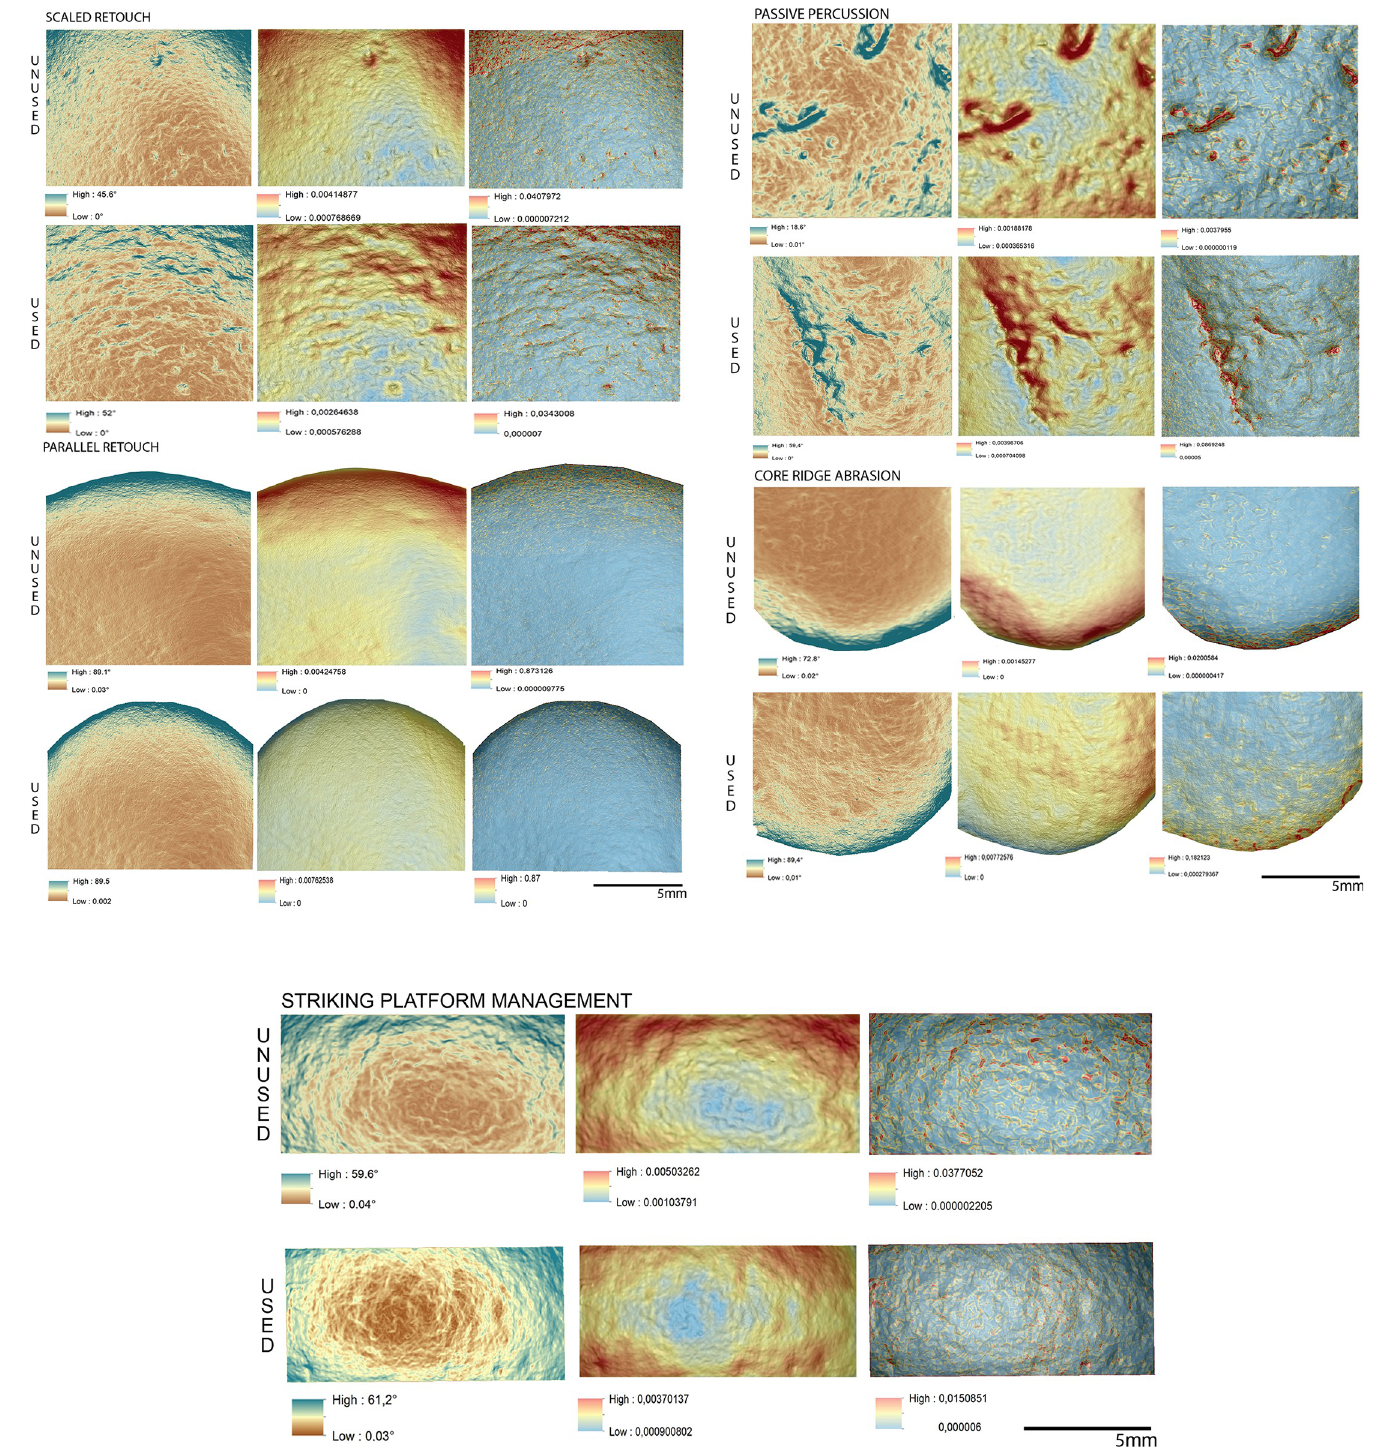
Fig 14. Comparison of the surface topography before and after the use of the tool to produce scaled and marginal retouch, percussion activities and bladelet production. Digital Surface Maps of Slope, TRI and VRM respectively.